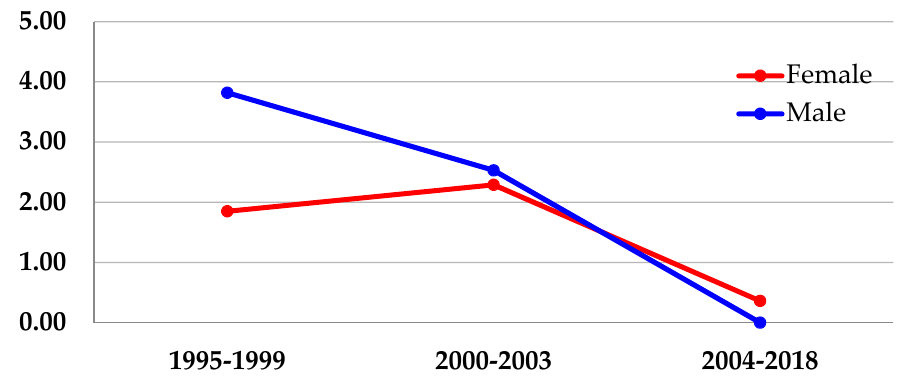
Figure 1. Incidence Rate (IR) of HIV-related Lymphoma for the Global cohort through Eras, by Sex. The IR of ADM diagnosis decreased (from 2.09–1.75–0.19 per 1000 children-year; p < 0.001) through the cART eras. It ranged from 0.74–1.83–0.36 lymphomas per 1000 children-year for females, p = 0.599, being non-significant; and decreased from 3.82–1.68–zero lymphomas per 1000 children-year for males, p < 0.001 (Table 2). The IR of NADM diagnosis also decreased (from 0.63–0.65–zero per 1000 children- year; p < 0.001) through the cART eras. It decreased from 1.10–0.45–zero lymphomas per 1000 children-year for females, p < 0.001; and ranged from zero–0.84–zero lymphomas per 1000 children-year for males, p = 0.728, being non-significant) (Table 2). The cumulative hazard of developing lymphoma for the global cohort in 20 years was 2.95%. Per era, it was 4.83% in Early-cART era, 4.20% in Mid-cART era, and 0.31% in Late-cART era ( p = 0.002). For ADM, per era, it was 3.73% in Early-cART era, 3.07% in Mid-cART era, and 0.32% in Late-cART era ( p = 0.013). Finally, for NADM, it was 1.10% in Early-cART era, 1.12% in Mid-cART era, and zero in Late-cART era, but non-significant ( p = 0.17) (Figure 2).